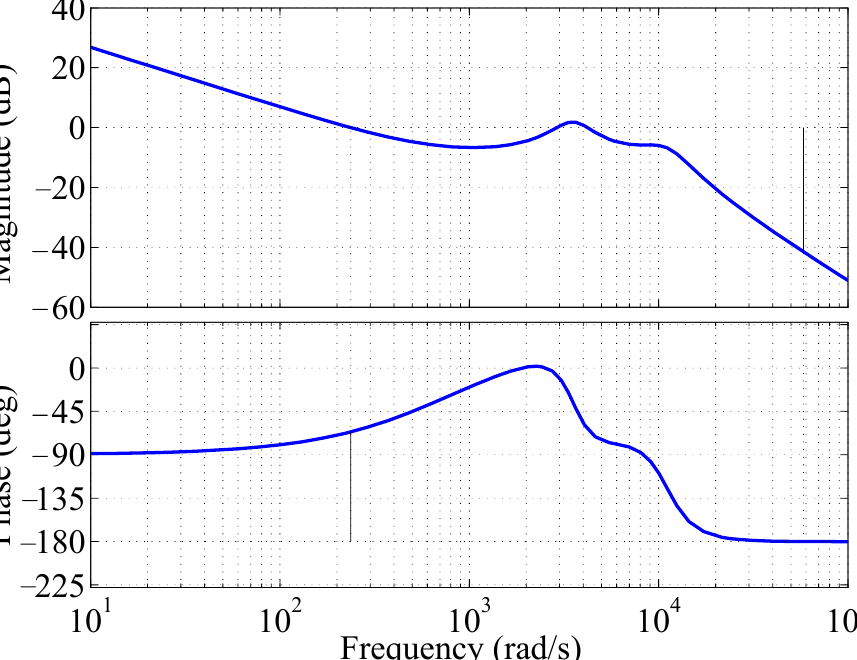
Figure 5. Open loop transfer function frequency response for 0.05 duty ratio with Gain of 16 multi- plied to the PI controller transfer